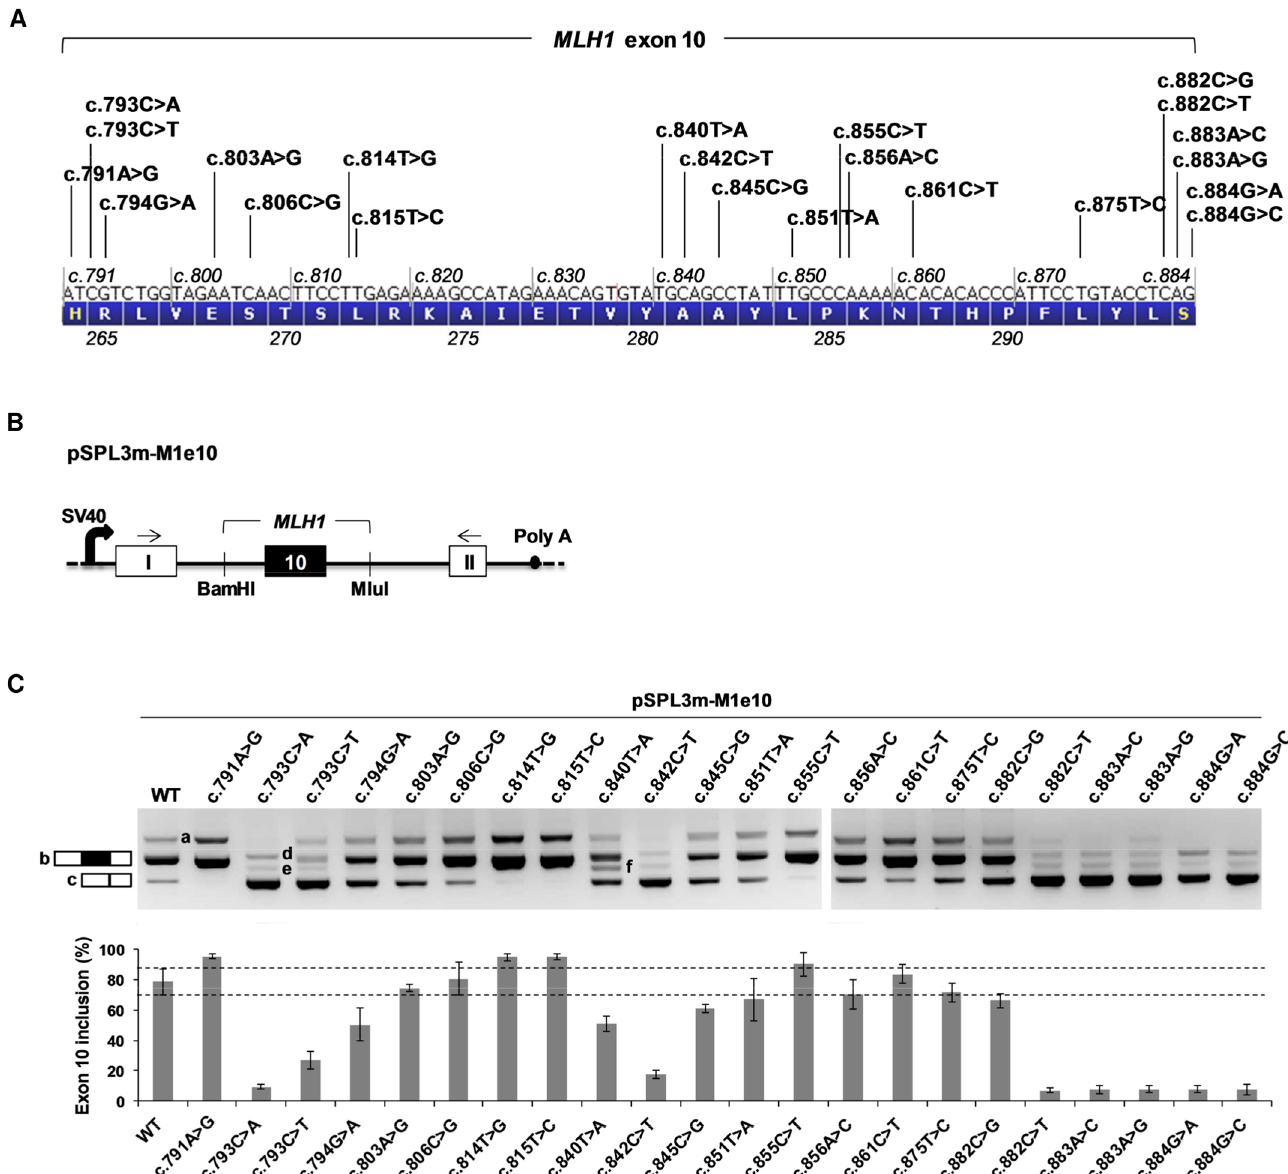
Fig 1. Identification of MLH1 exon 10 splicing mutations by using a pSPL3m-M1e10 minigene splicing reporter assay. (A) Distribution of all SNVs reported in MLH1 exon 10 (n = 22). The diagram shows the nucleotide composition of MLH1 exon 10 (c.791-c.884) and the corresponding amino-acid sequence (1-letter code, p.264-p.295), as well as the position and identity of each SNV. (B) Structure of the pSPL3m-M1e10 minigenes used in the splicing reporter assay. Boxes represent exons and lines in between indicate introns. The minigenes were generated by inserting a genomic fragment containing MLH1 exon 10 and upstream/downstream flanking intronic sequences (168/187 nucleotides, respectively) into the intron of pSPL3m, as described under Materials and Methods. Arrows above the exons represent RT-PCR primers used in the splicing reporter assay. SV40, SV40 promoter; Poly A, polyadenylation site. (C) Analysis of the splicing pattern of pSPL3m-M1e10 minigenes containing the variants indicated in (A). Wild-type (WT) and mutant pSPL3m-M1e10 constructs were transfected into HeLa cells and then the minigenes ’ transcripts were analyzed by RT-PCR as described under Materials and Methods. The top panel shows the RT-PCR products, obtained for WT and mutant constructs as indicated, separated on a 2.5% agarose gel stained with ethidium bromide. The identities of the two major RT-PCR products, with or without exon 10 (b and c, respectively), are indicated on the left. All the products (a, b, c, d, e and f) are described in detail in S1 Fig, f corresponding to RT-PCR products containing exon 10 deleted of the last 48 nucleotides. The bottom panel shows the quantification of the RT-PCR products. Results are shown as the average of three independent experiments and are expressed as percentage of exon inclusion ([exon inclusion products (a+b) x 100/total transcripts]). Error bars indicate individual standard deviation (SD) values, whereas the horizontal dashes delineate the limits of the SD bar obtained for WT (79 ± 9; i.e. 70% and 88% exon inclusion). Variants producing exon inclusion levels outside this range were considered as splicing